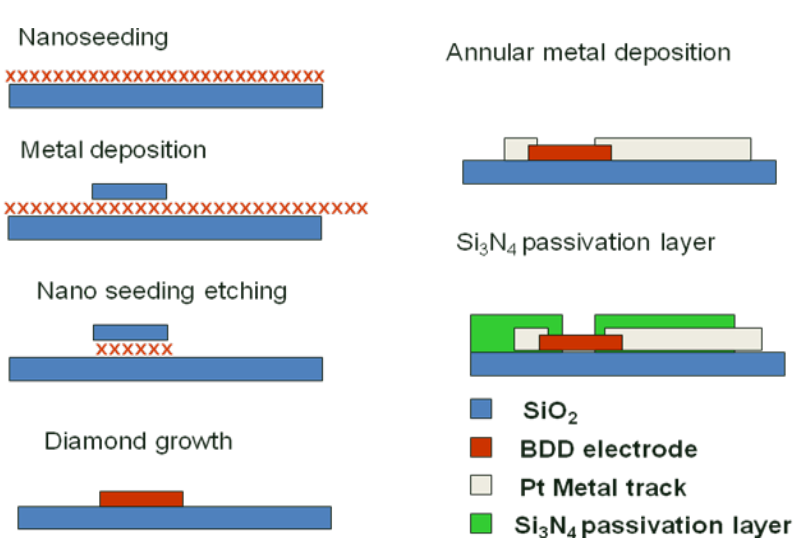
Figure 1. Schematics of diamond ultramicroelectrode array fabrication